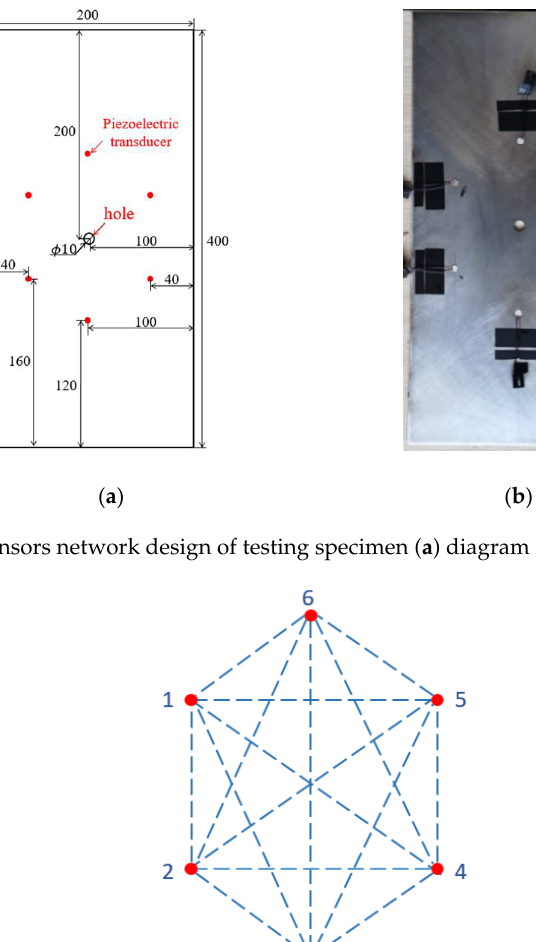
( b ) Figure 6. ( a ) Geometrical dimensions (mm) and ( b ) appearance of piezoelectric sensors. Table 2. Performance of piezoelectric sensor. Product Number